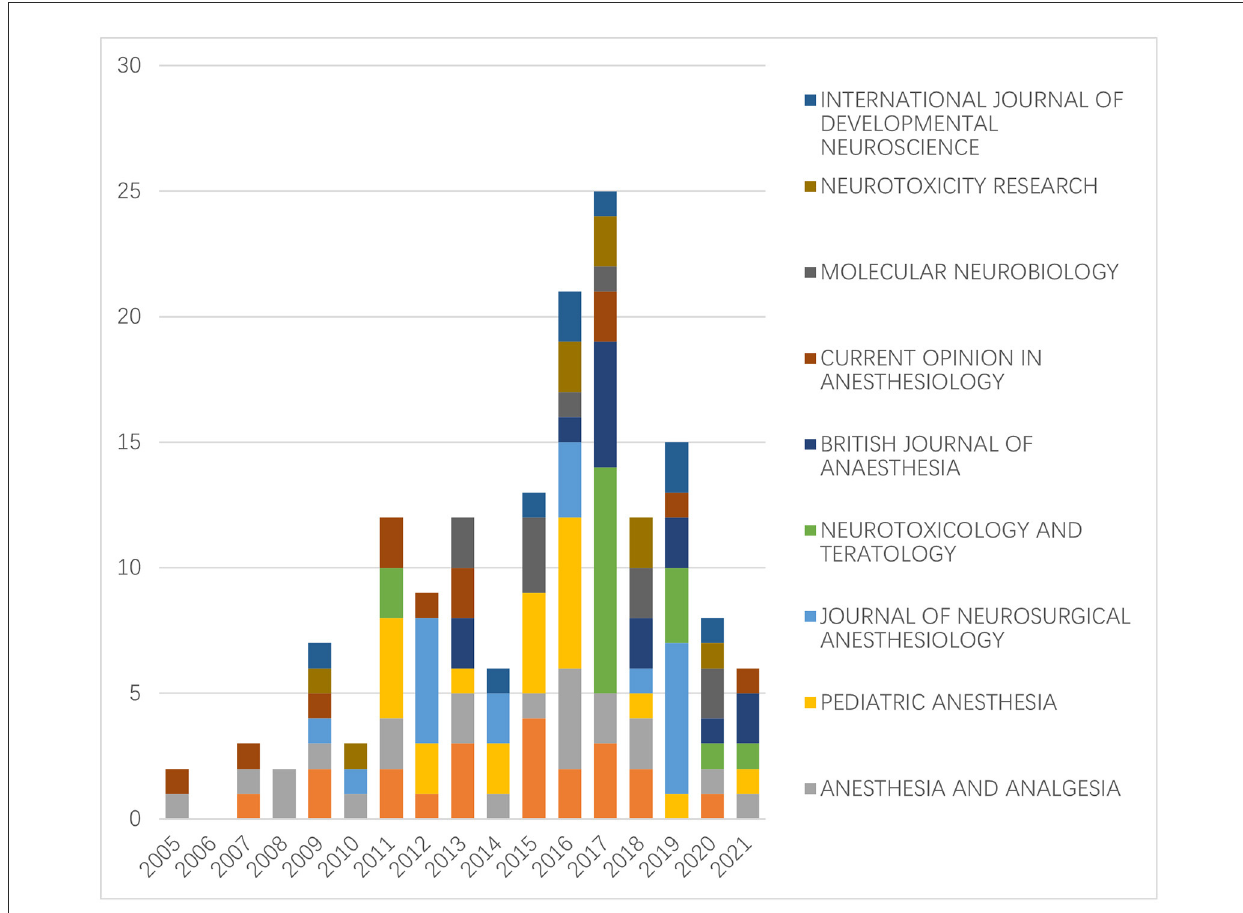
FIGURE4 The number of articles on the neurotoxicity of anesthesia in the developing brain published in the top 10 journals each year (no publications in this field in the top 10 journals prior to